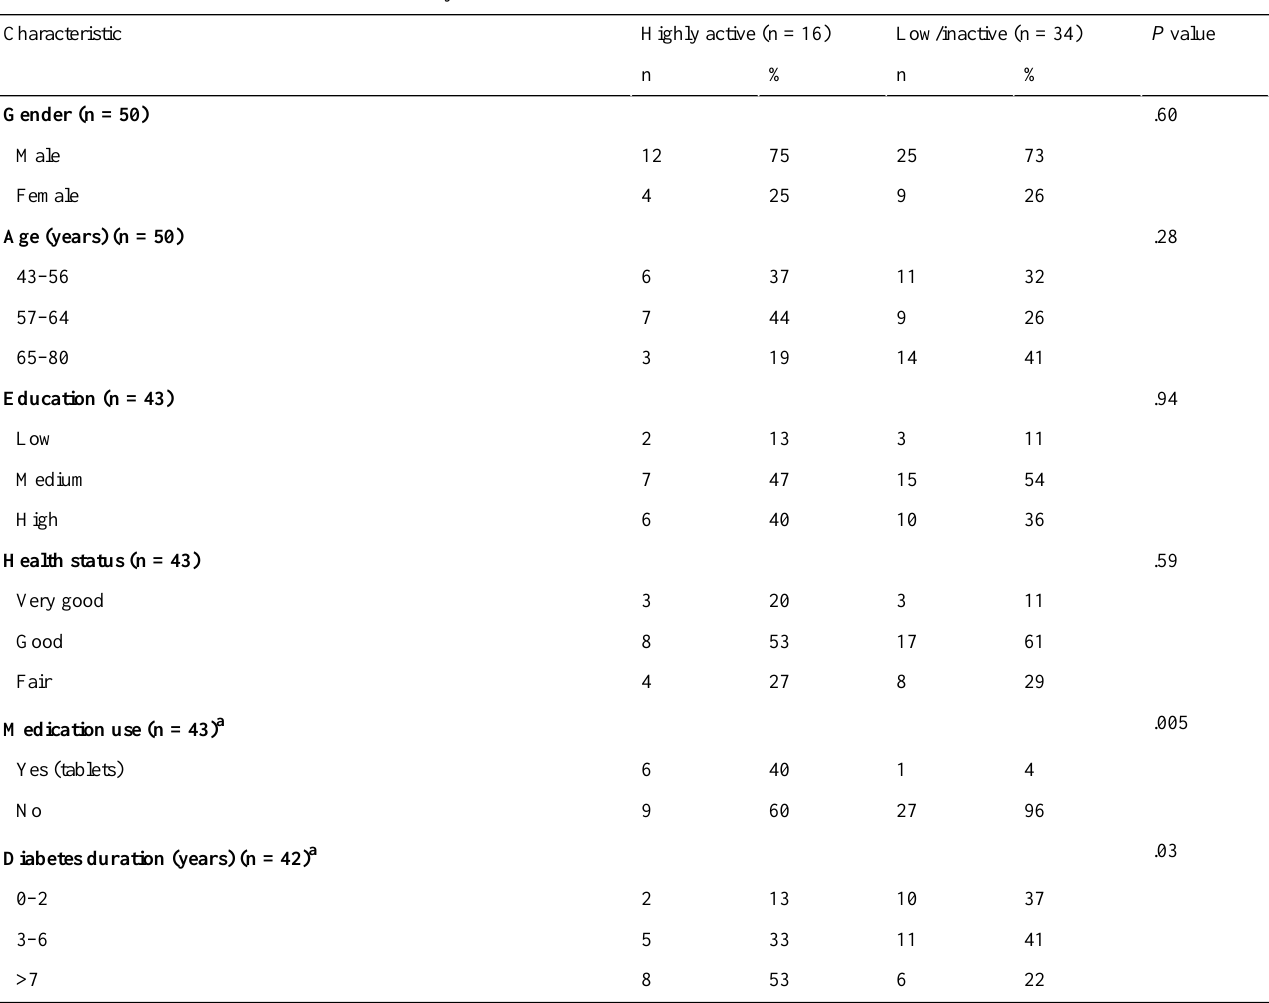
Table 4. Patient characteristics related to user activity